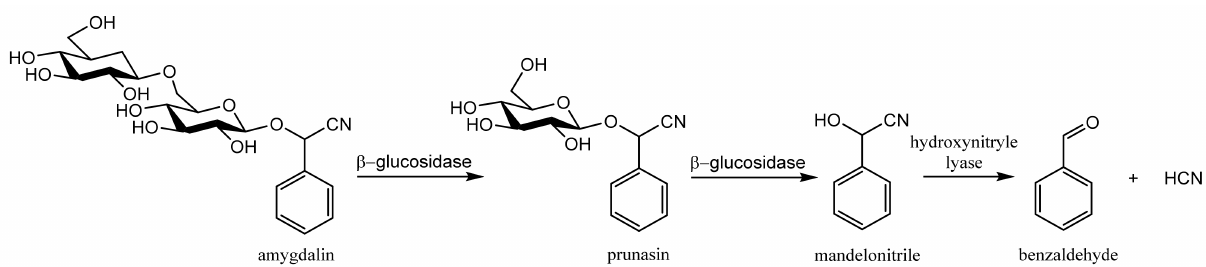
Figure 2. Hydrogen cyanide formation as a result of hydrolysis of